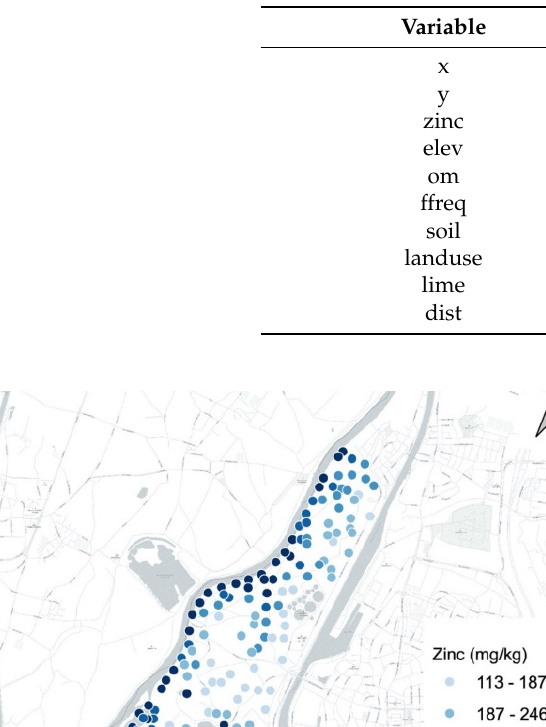
Table 1. Variable description of Meuse River dataset.